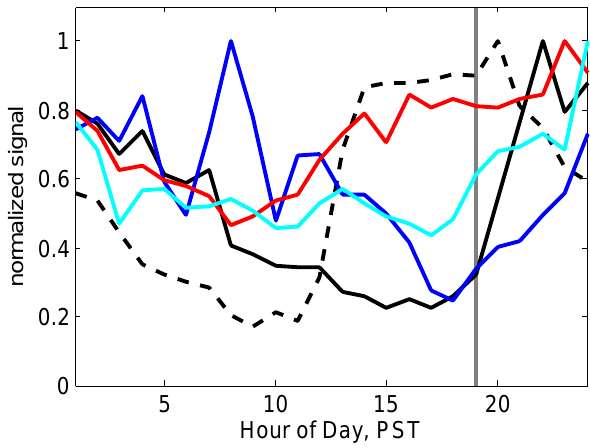
Fig. 5. Average, normalized diurnal signal of the m/z 316 prod- uct, proposed as the nitrooxyhydroperoxide from α -pinene (solid black line); m/z 300 product, proposed as the hydroxynitrate from α -pinene (solid blue line); m/z 248 product, proposed as the ni- trooxyhydroperoxide from isoprene (solid red line); m/z 230, pro- posed as the nitrooxycarbonyl from isoprene (solid cyan line). For reference, the signal for ISOPN is shown as the dashed line. The solid gray line indicates the approximate time of local